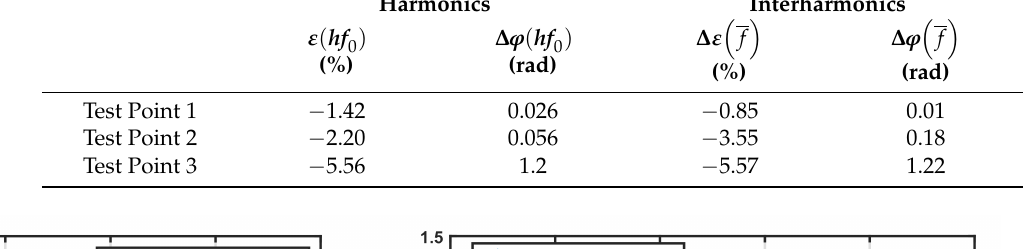
Table 13. Ratio and phase errors of LPVT in harmonics and interharmonic measurements. Harmonics